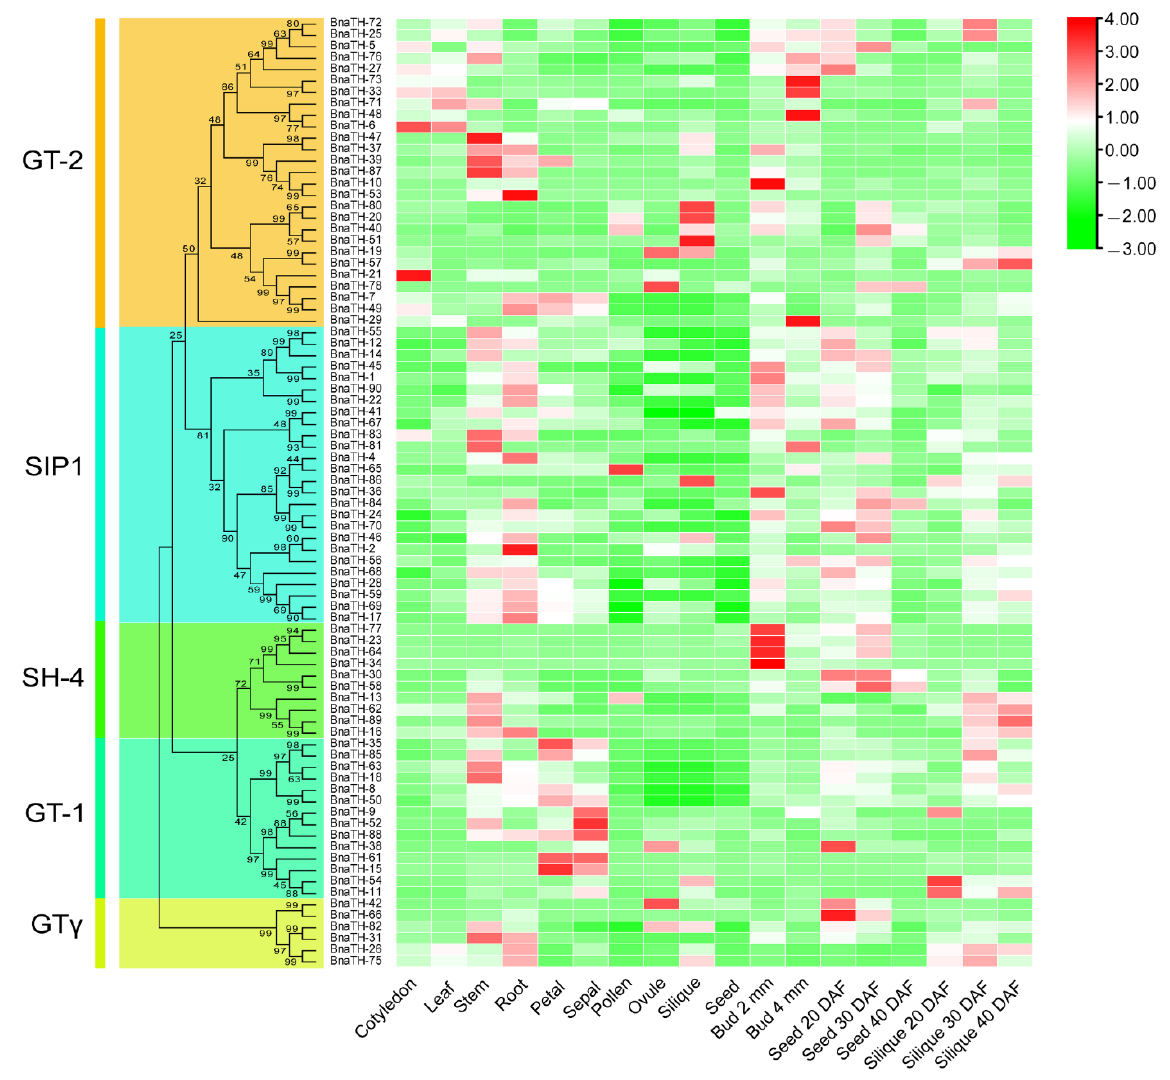
Figure 8. Expression pattern of BnaTH in different tissues and different developmental stages. The subgroup distribution and phylogenetic tree of BnaTH are shown on the left. FPKM values of BnaTH genes transformed by log2 were used in TBtools to construct heat maps. Expression levels are depicted by the different colors on the scale. Red and green represent high and low expression levels respectively.